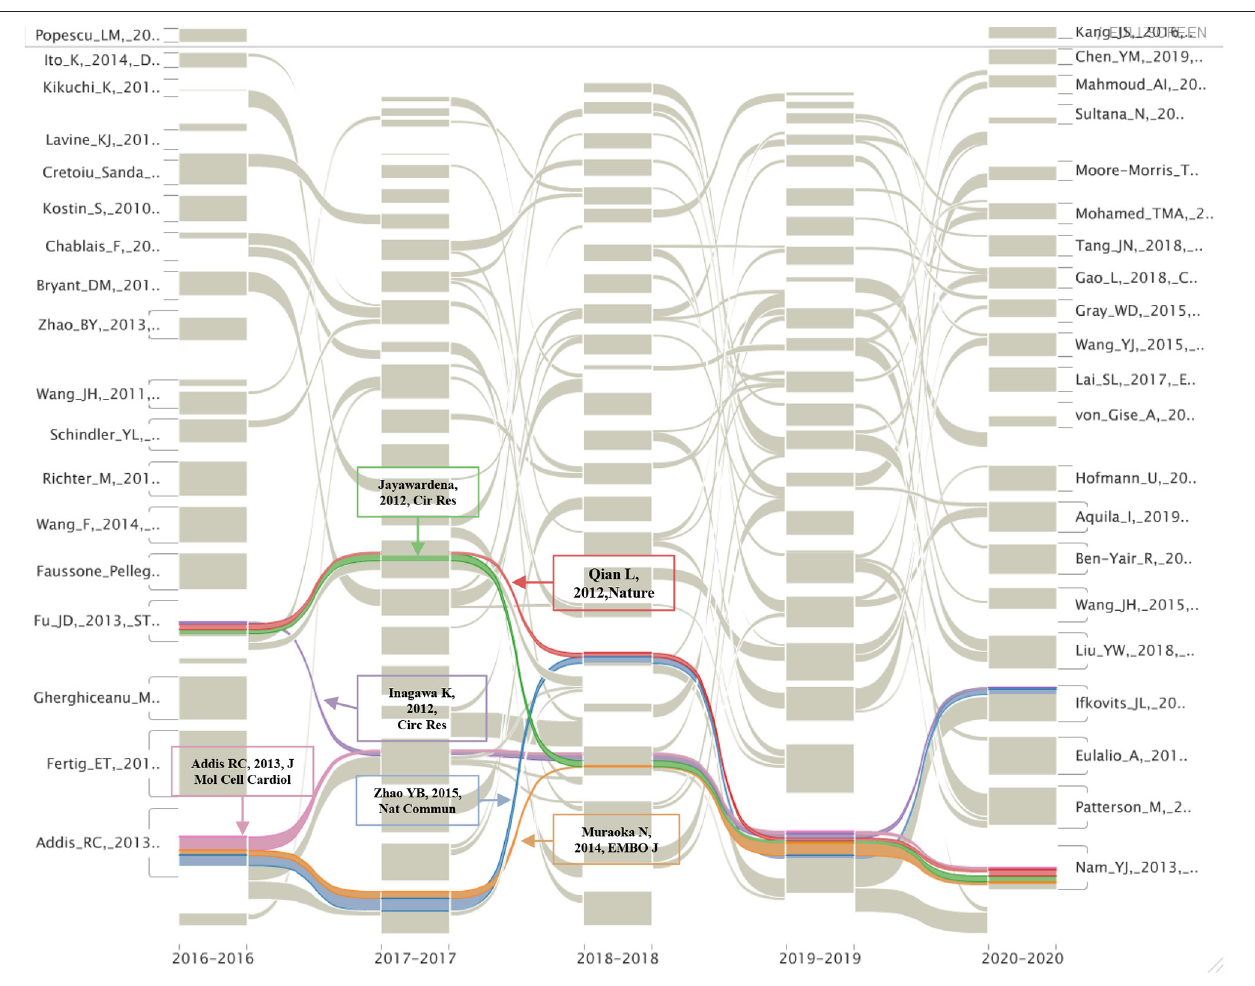
FIGURE 6 | The alluvial flow map of co-cited references in the last 5 years. Each line represented a study, and colored and continuous lines referred to articles that had been consistently cited in the past 5